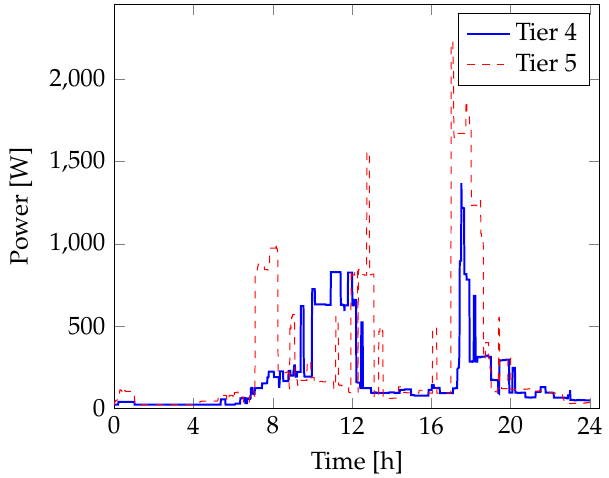
Figure 1. 1-day load profiles for tier 4 and tier 5 levels of electricity consumption. Data sourced from [31].